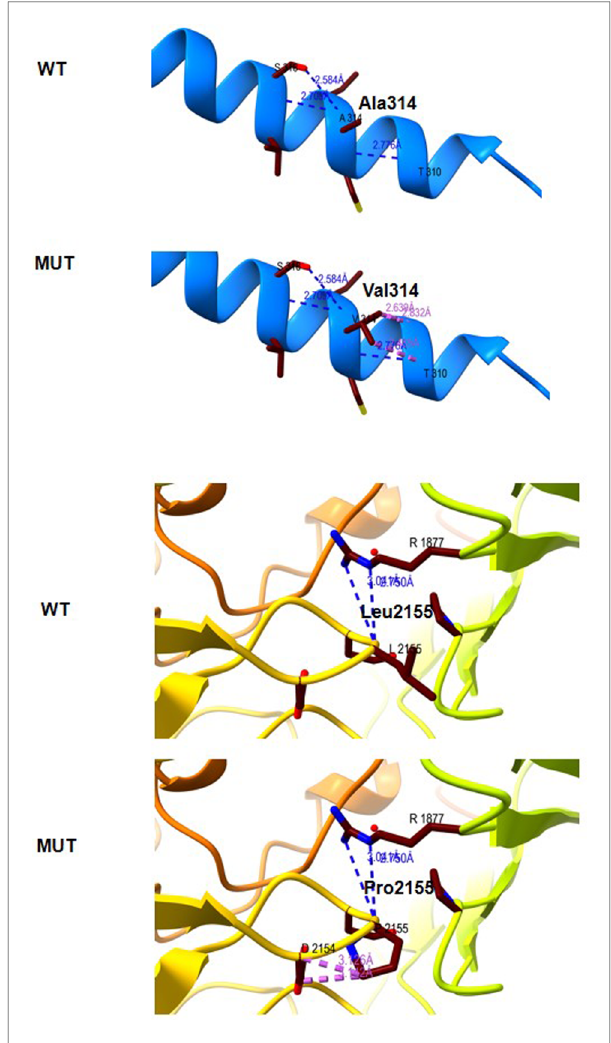
FIGURE 4 Molecular modeling of the wild type (WT) and mutant TENM3 protein (Mut). Three-dimensional structural modeling of the TENM3 protein showed that the mutations did not change the hydrogen bonding in protein (blue), but repulsive force (purple) was generated between the R group of amino acid side chain and other nearby